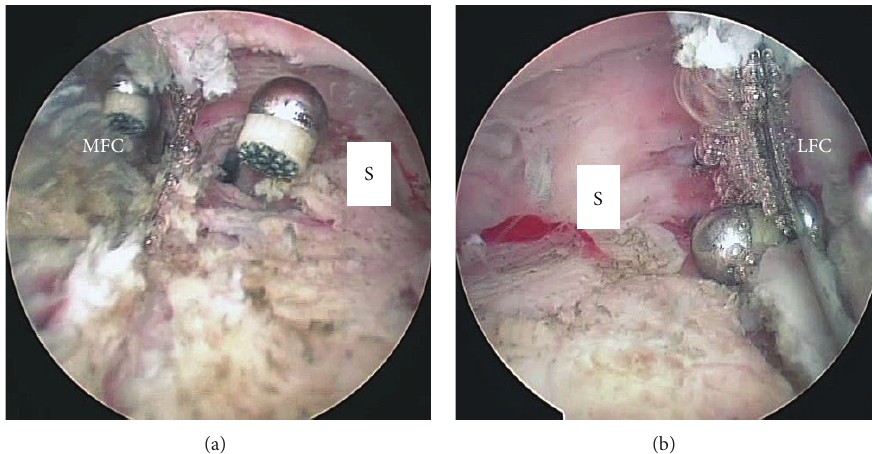
Figure 6: Arthroscopic views during debridement and synovectomy in the posterior compartment. Debridement and synovectomy in the posteromedial (a) and posterolateral (b) compartments were performed with a radiofrequency abrader that was introduced from the posterolateral (a) and posteromedial (b) portal through the posterior transseptal portal. S, septum; MCF, medial condyle of the femoral component; LCF, lateral condyle of the femoral